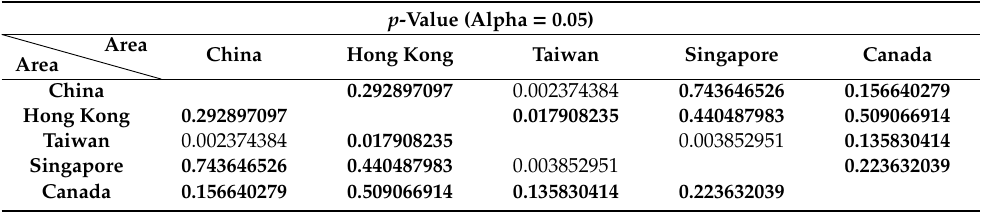
Table 4. p -value of every two areas on the daily changing rate of infected case number.